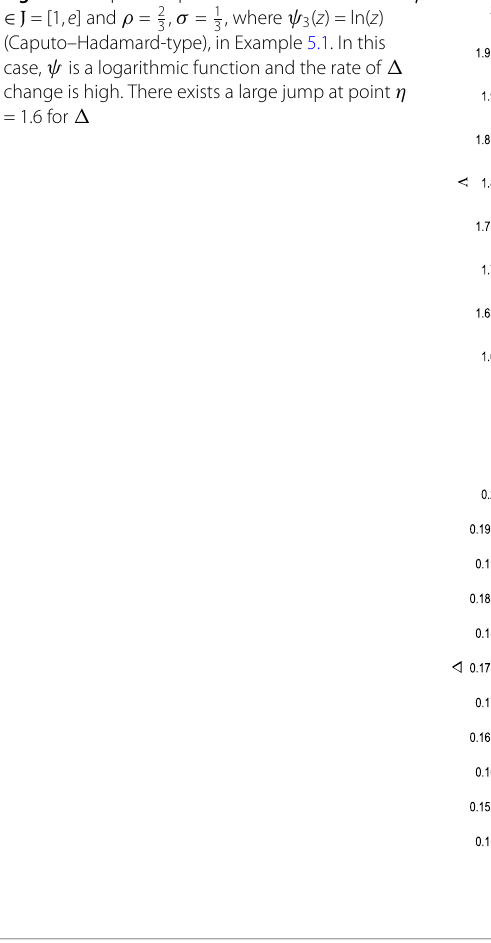
Figure 3 Graphical representation of (cid:25) and (cid:27) for η ∈ J = [1, e ] and ρ = 2 , σ = 1 , where ψ 3 ( z ) = ln( z ) 3 3 (Caputo–Hadamard-type), in Example 5.1. In this case, ψ is a logarithmic function and the rate of (cid:27) change is high. There exists a large jump at point η = 1.6 for